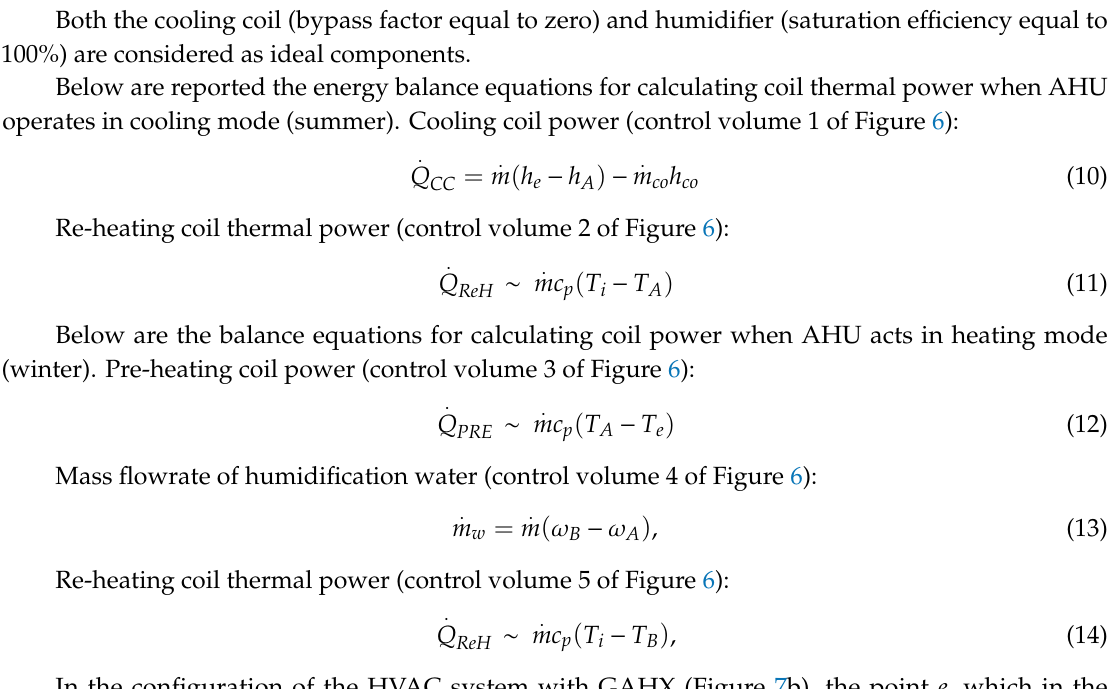
Figure 7. Processes of the humid air on the psychometric chart into the AHU during: ( a ) summer and ( b )